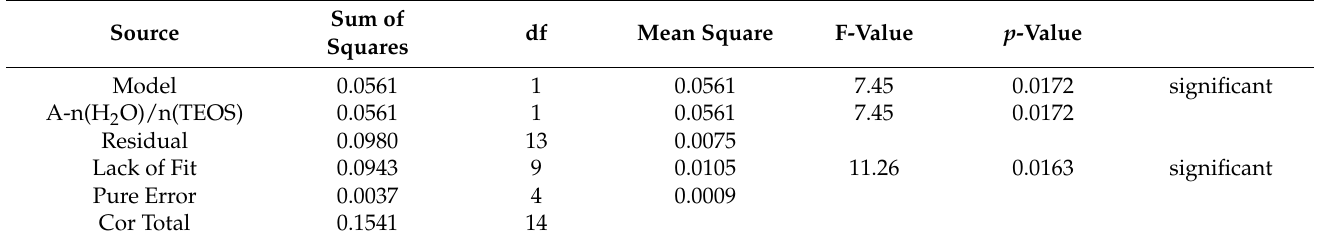
Table A1. Analysis of variance (ANOVA) for the analysis of the FCD design of the median parti- cle size.